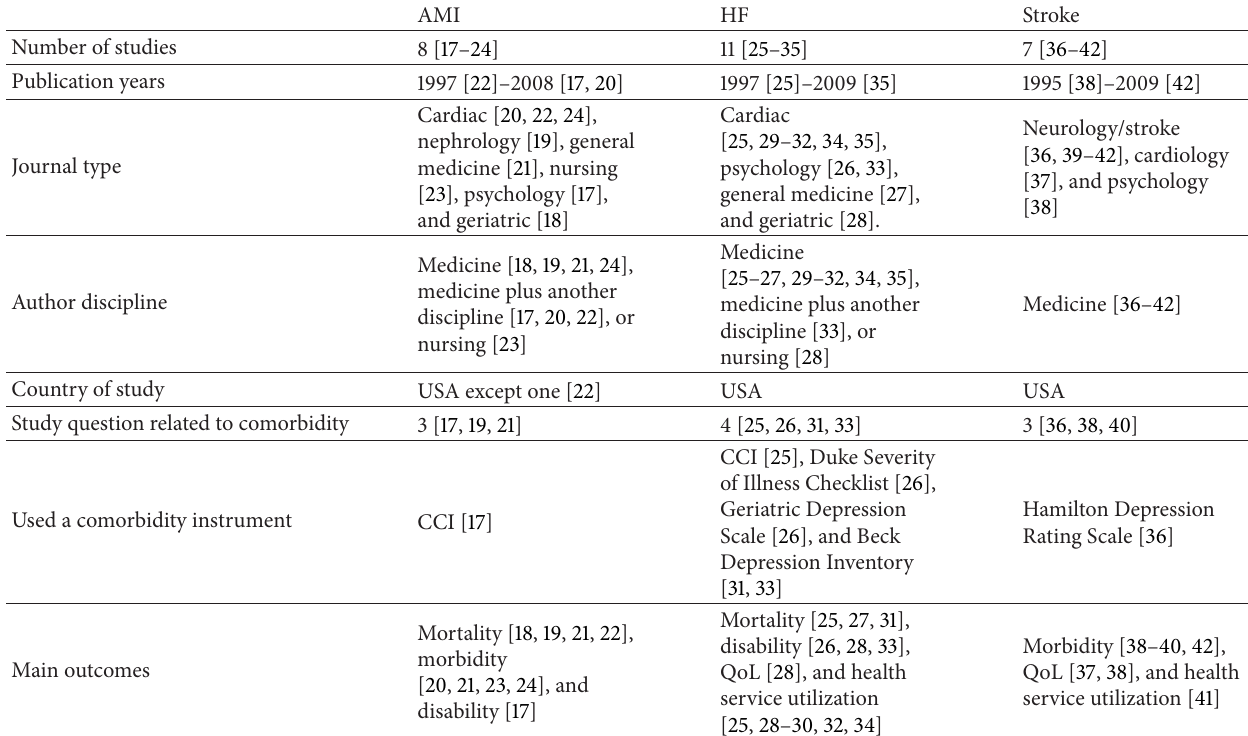
Table 2: Demographics of the studies by